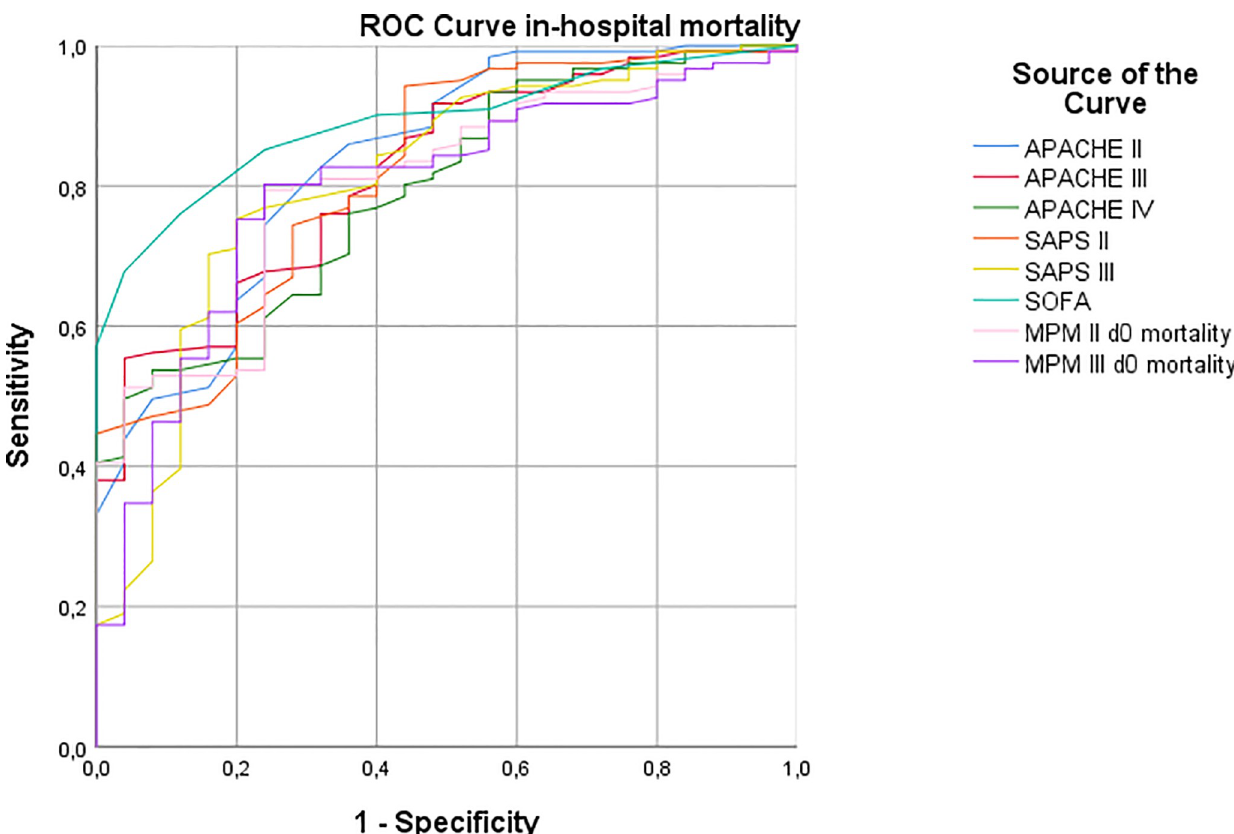
Fig 1. ROC curve analysis. In-hospital mortality ROC curve of the tested predictive scores. APACHE: Acute Physiology Assessment and Chronic Health Evaluation, SAPS: Simplified Acute Physiology Score, SOFA: Sequential Organ Failure Assessment, MPM: Mortality Prediction Model.